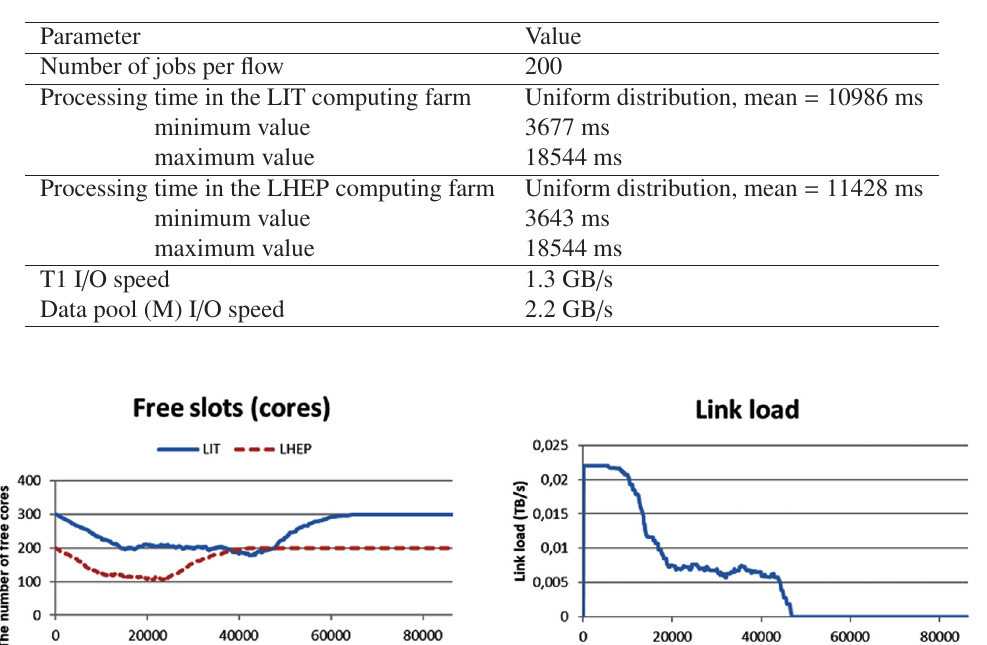
Table 1. Additional input parameters for